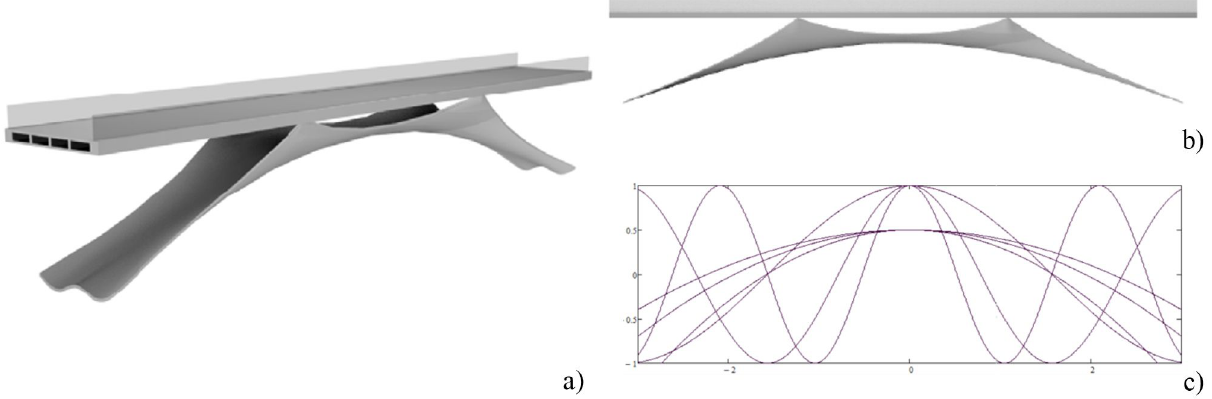
Figure 5: Shell-supported footbridge: (a) Perspective view; (b) lateral view; (c) parametric variation of the shell edge at the abutments to choose its optimum